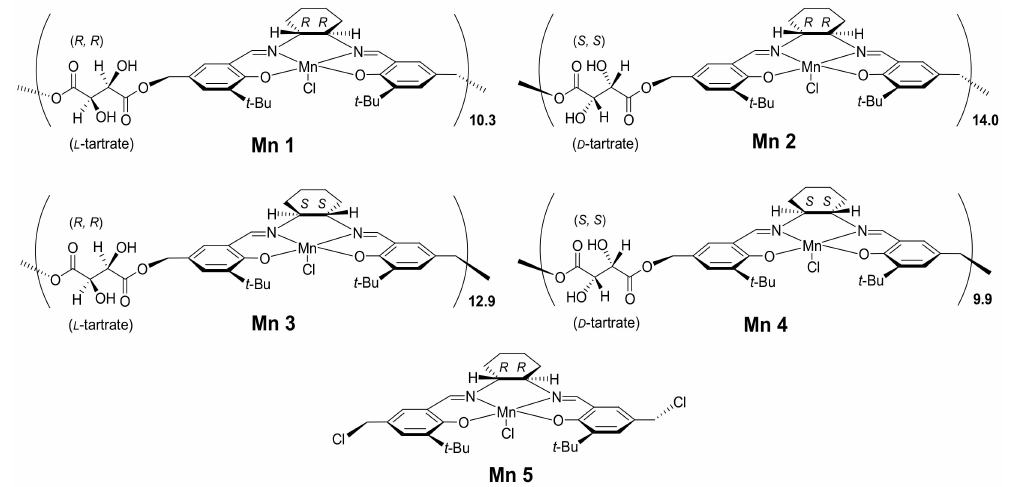
Figure 1. Structural illustration of the synthesized (tartrate-salen)Mn(III)